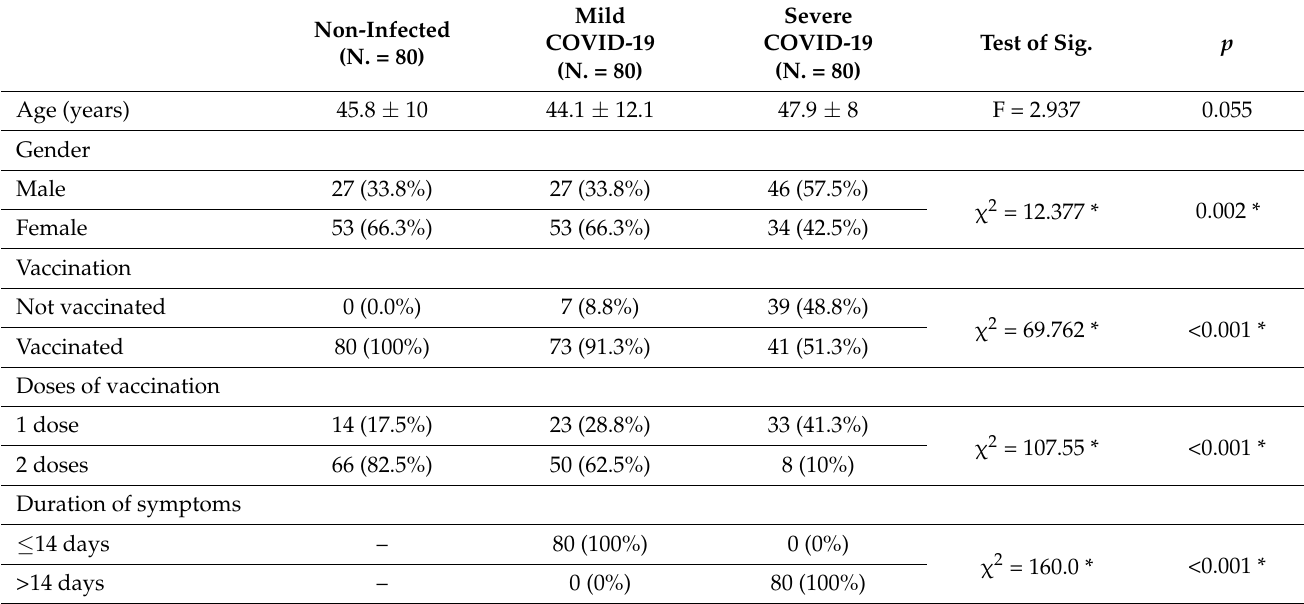
Table 1. Comparison between the studied groups according to demographic and clinical